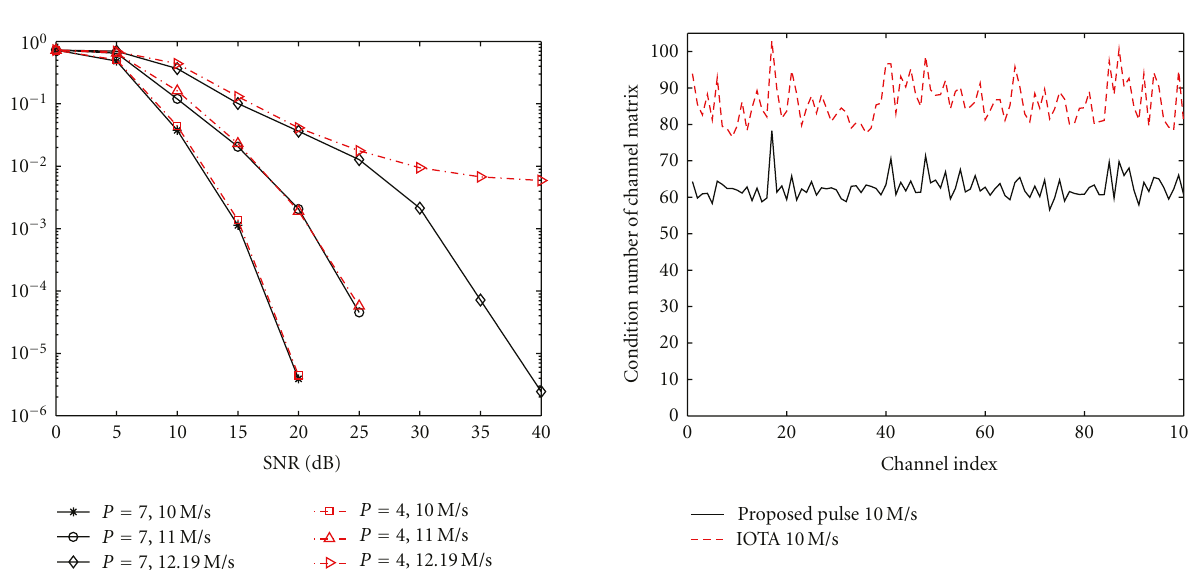
Figure 9: Condition number comparison for di ff erent pulses, with CFOs randomly chosen within the range [0,0 . 001 /T s ].